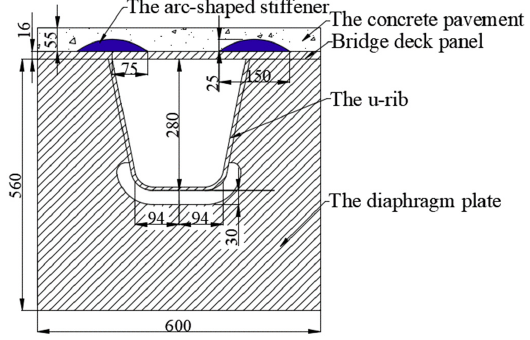
Figure 4. The layout of the OSD with arc-shaped stiffener (mm).